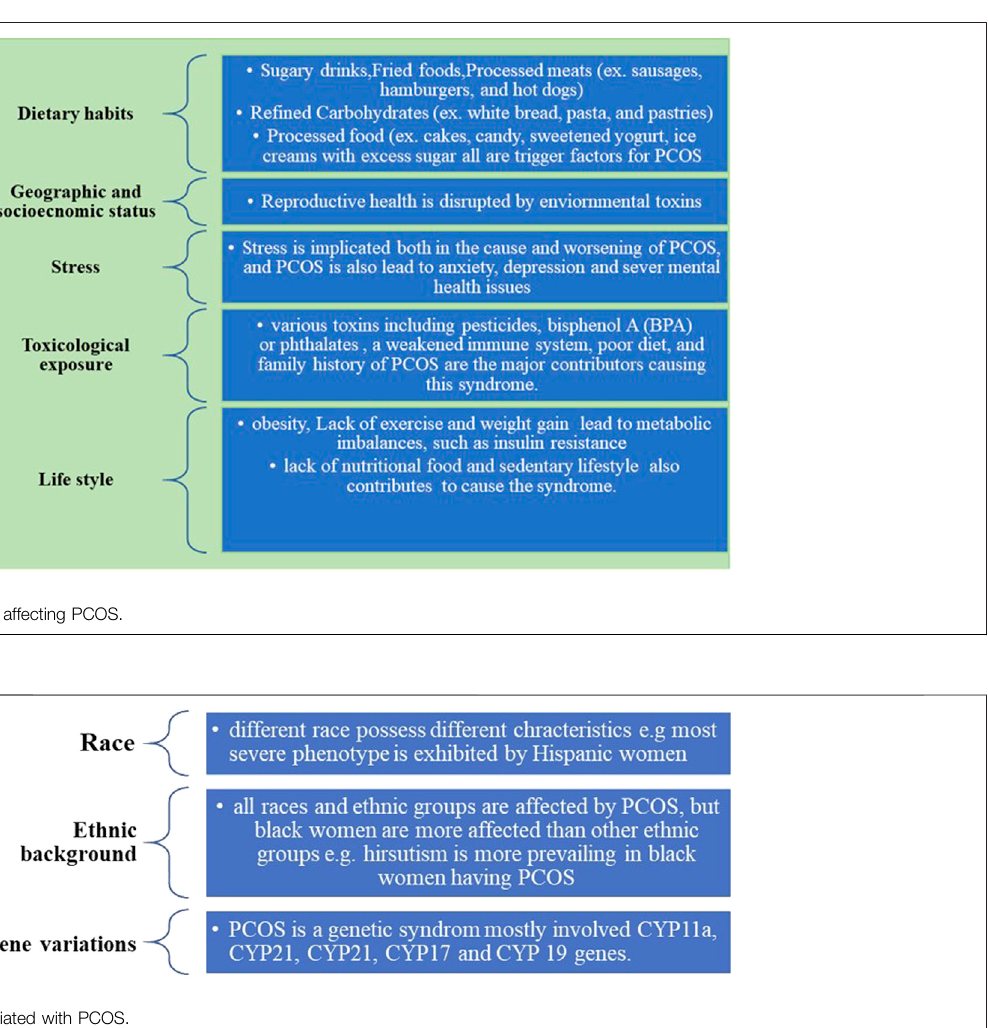
FIGURE 2 | Genetic factors associated with